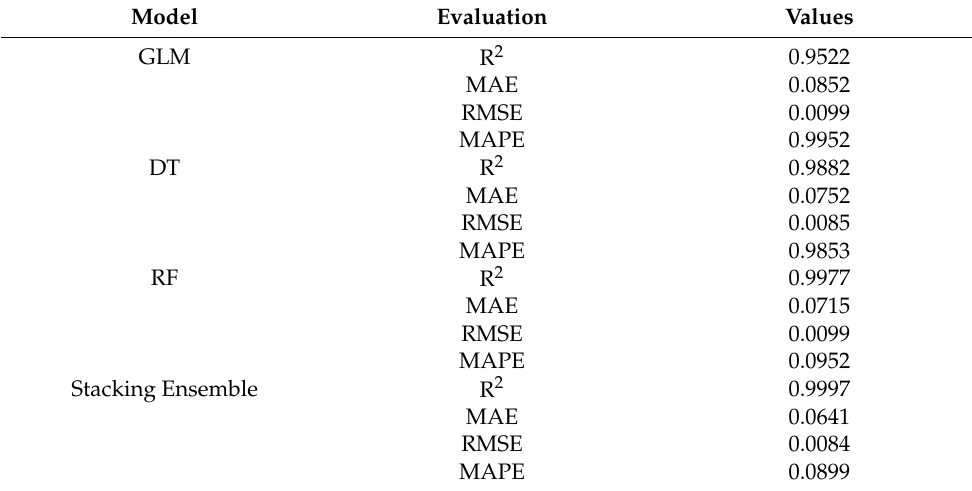
Table 1. Evaluation of model